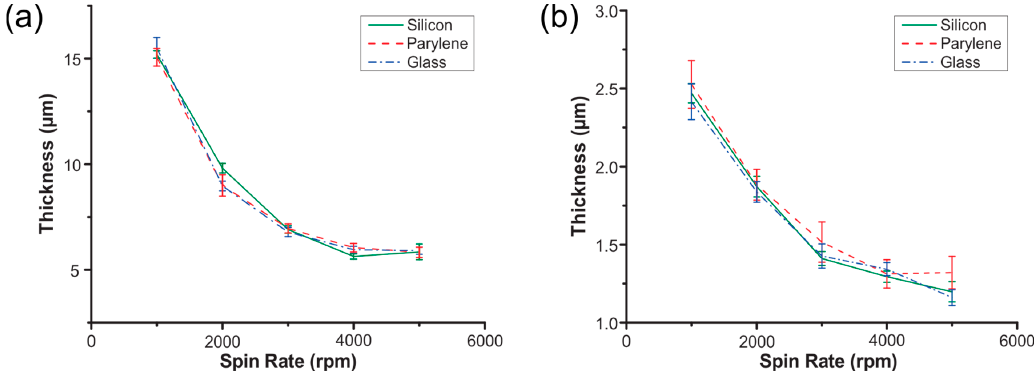
Figure 13. Spin curves for ( a ) AZ P4620 and ( b ) AZ 5214E-IR resists on silicon, glass and Parylene. Error bars represent standard deviation ( n = 5).